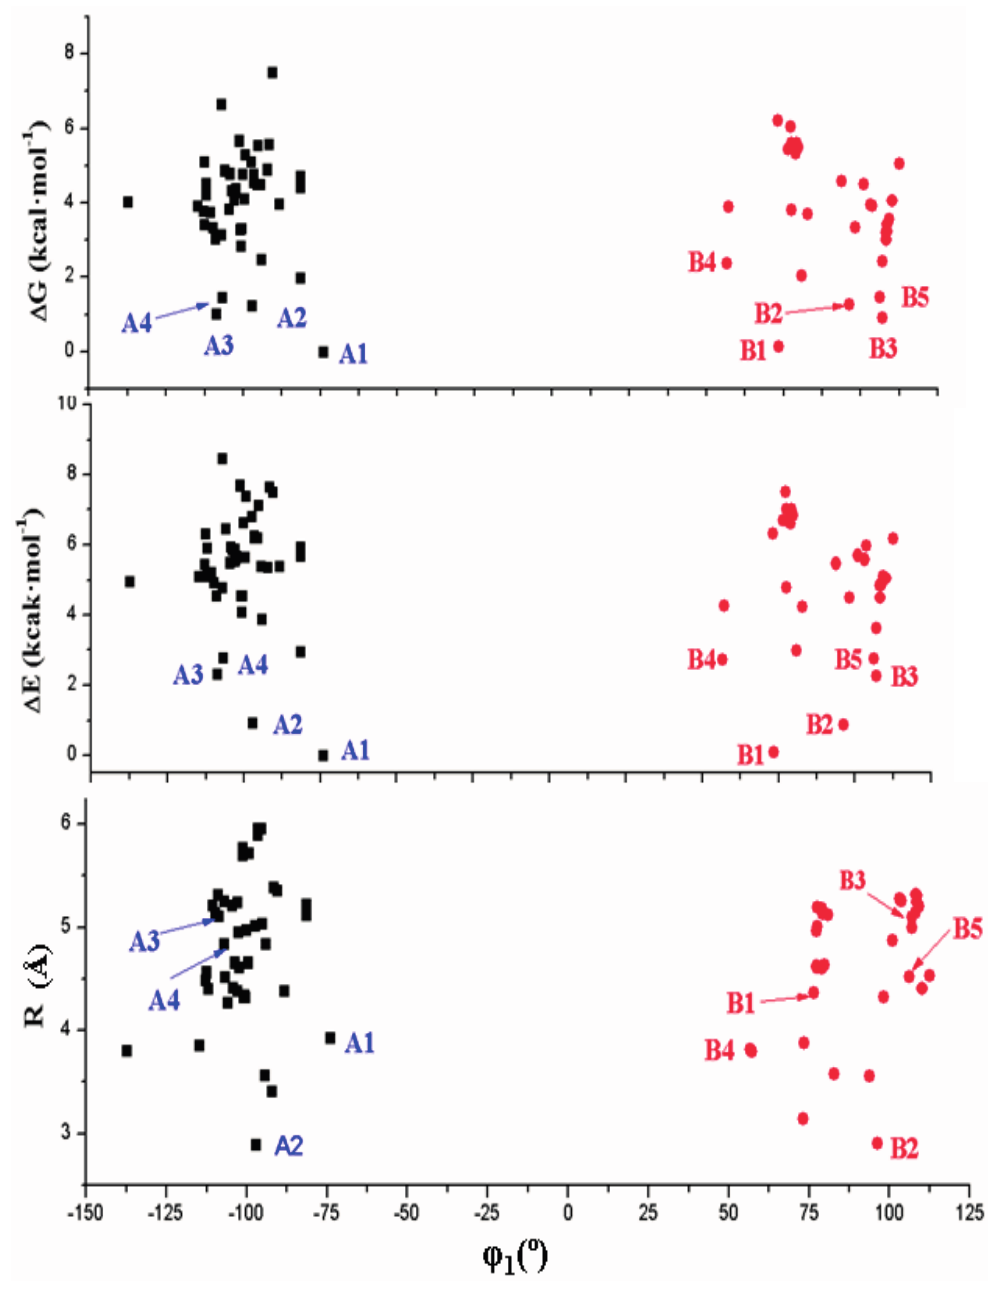
Figure 6. Distribution of the 78 optimum stable calculated conformers at the B3LYP/6- 31G(d,p) level in tautomer N1 of acyclovir according to their exocyclic torsional angle φ and their: ( a ) relative electronic energy Δ E + ZPE correction; ( b ) relative Gibbs energy Δ G ; and ( c ) the distance R. The most stable conformers of each type are